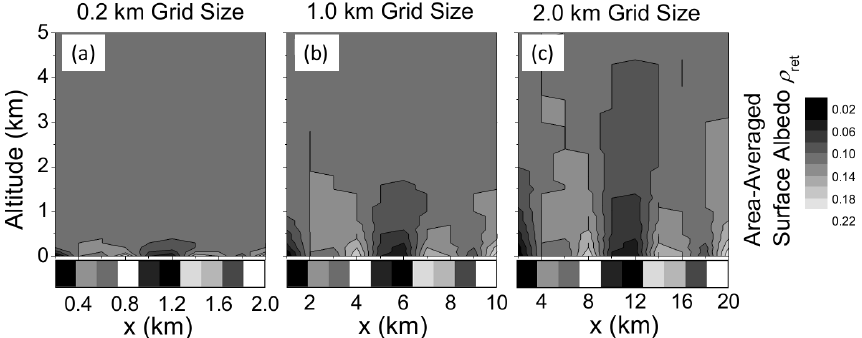
Fig. 6. Vertical cross-section of the retrieved area-averaged surface albedo ρ ret for (a) 0.2, (b) 1km, and (c) 2km resolution at 450nm